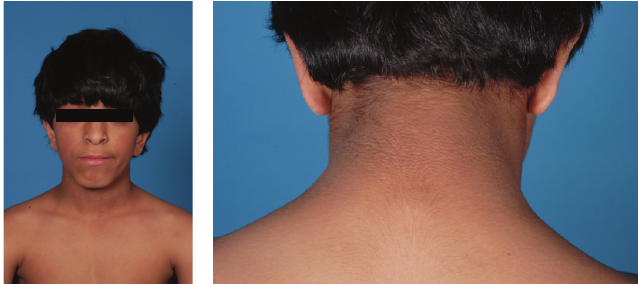
Figure 3: Acanthosis nigricans around the patient’s